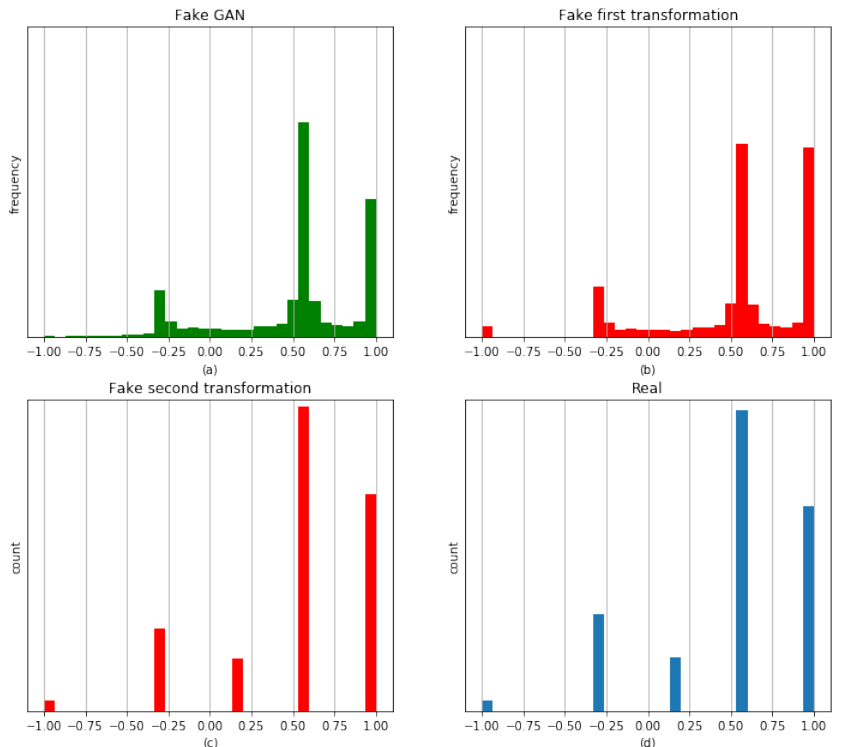
Figure 4. Distribution of the data for the feature Node for the synthetic database ( a ), after the first transformation ( b ) and the second transformation ( c ), and that from the real patients ( d